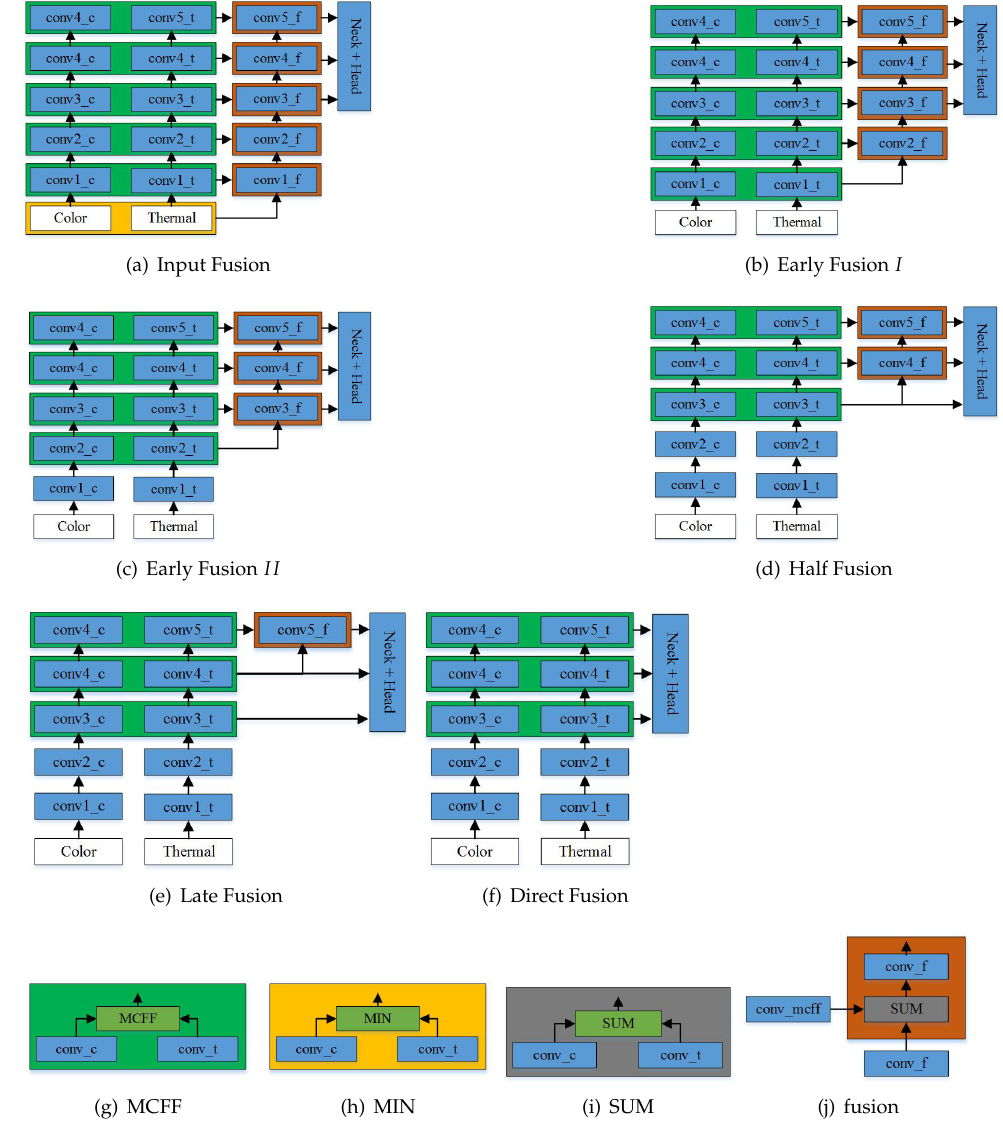
Figure 3. An overview of the fusion architectures. ( a – f ) Six fusion architectures that we proposed. ( g – i ) Fusion methods used in panels ( a – f ). The green, yellow, and black fusion blocks are the MCFF, MIN, and SUM, respectively. ( j ) was used to fuse features from the MCFF and conv − f